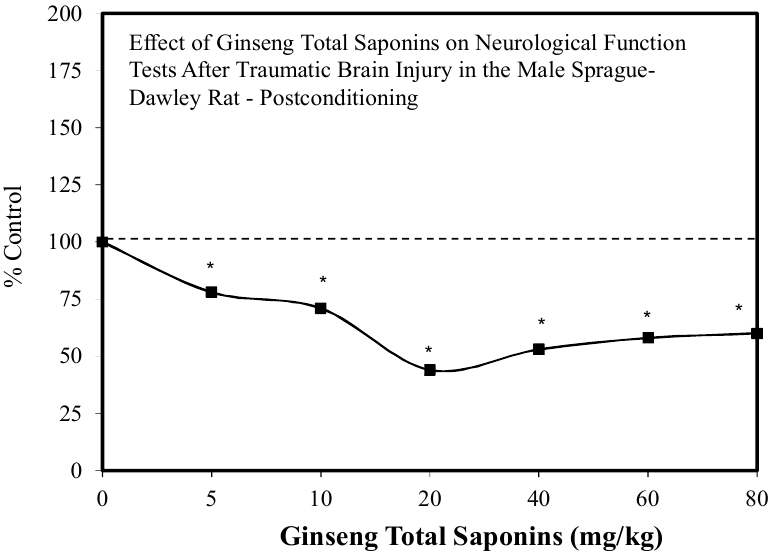
Figure 47. E ff ect of ginseng total saponins on neurological function tests after traumatic brain injury in the male Sprague–Dawley rat post-conditioning (source: [23]).